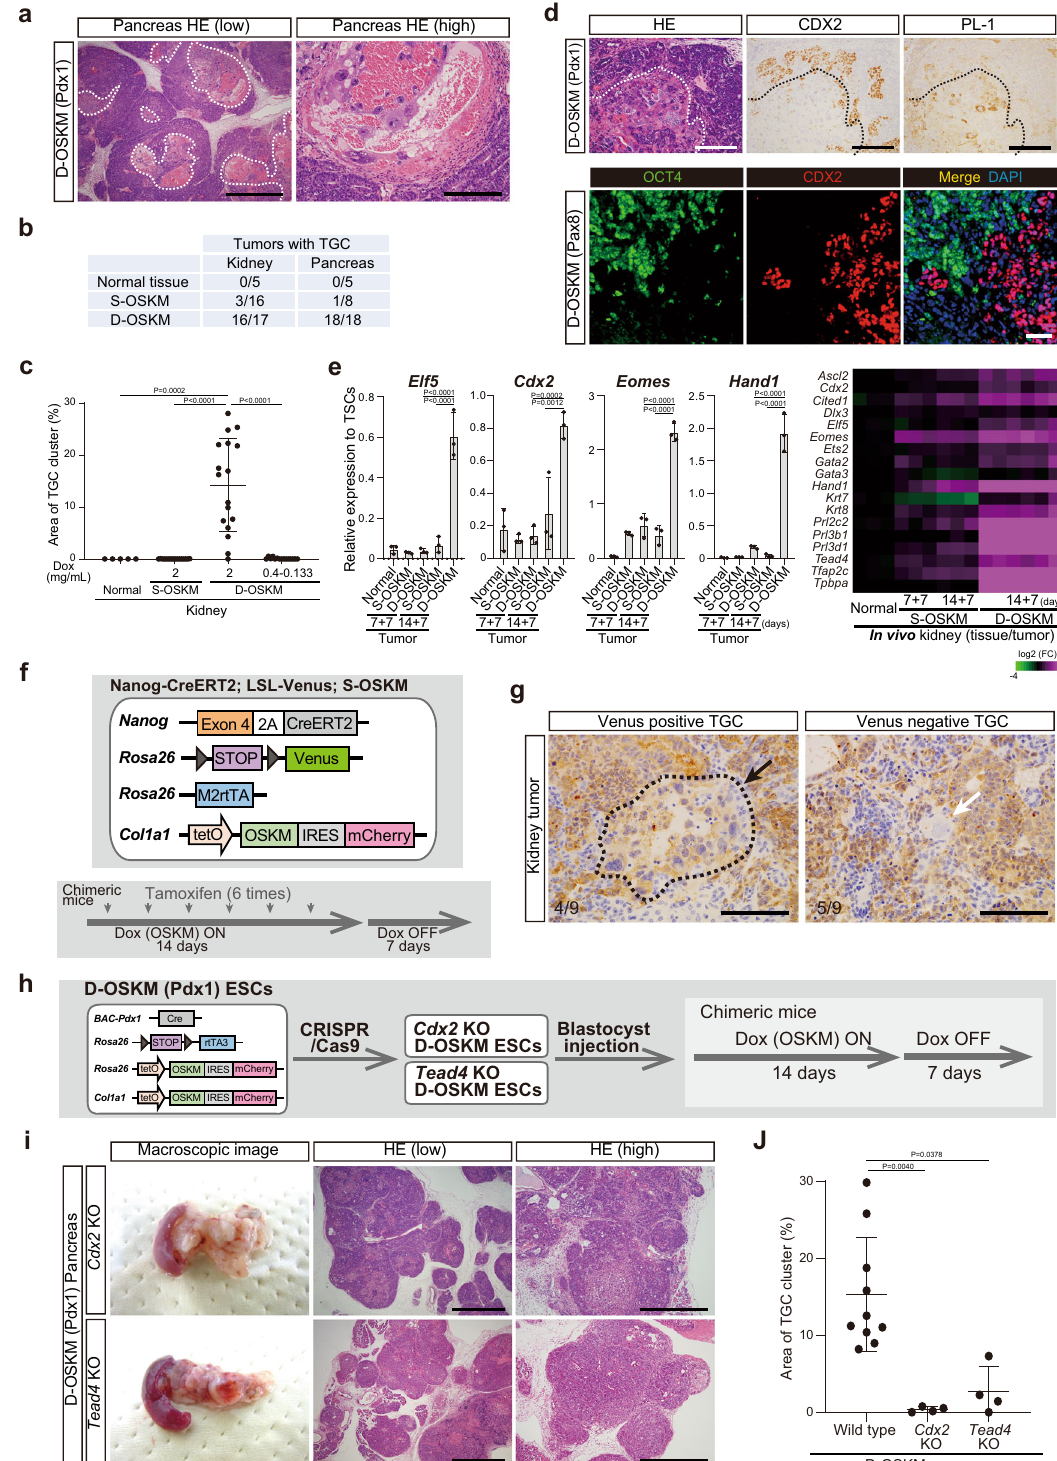
trophoblastic differentiation in D-OSKM tumors, we next established D-OSKM chimeric mice de fi cient for Tead4 or Cdx2 (Fig. 3h and Supplementary Fig. 3c,d). Although Tead4- or Cdx2 - knockout (KO) D-OSKM mice developed tumors, the number of trophoblast giant cells was remarkably reduced (Fig. 3i, j and Supplementary Fig. 3d,e), suggesting that the machinery involved in trophoblastic differentiation in D-OSKM tumors is similar to that in preimplantation